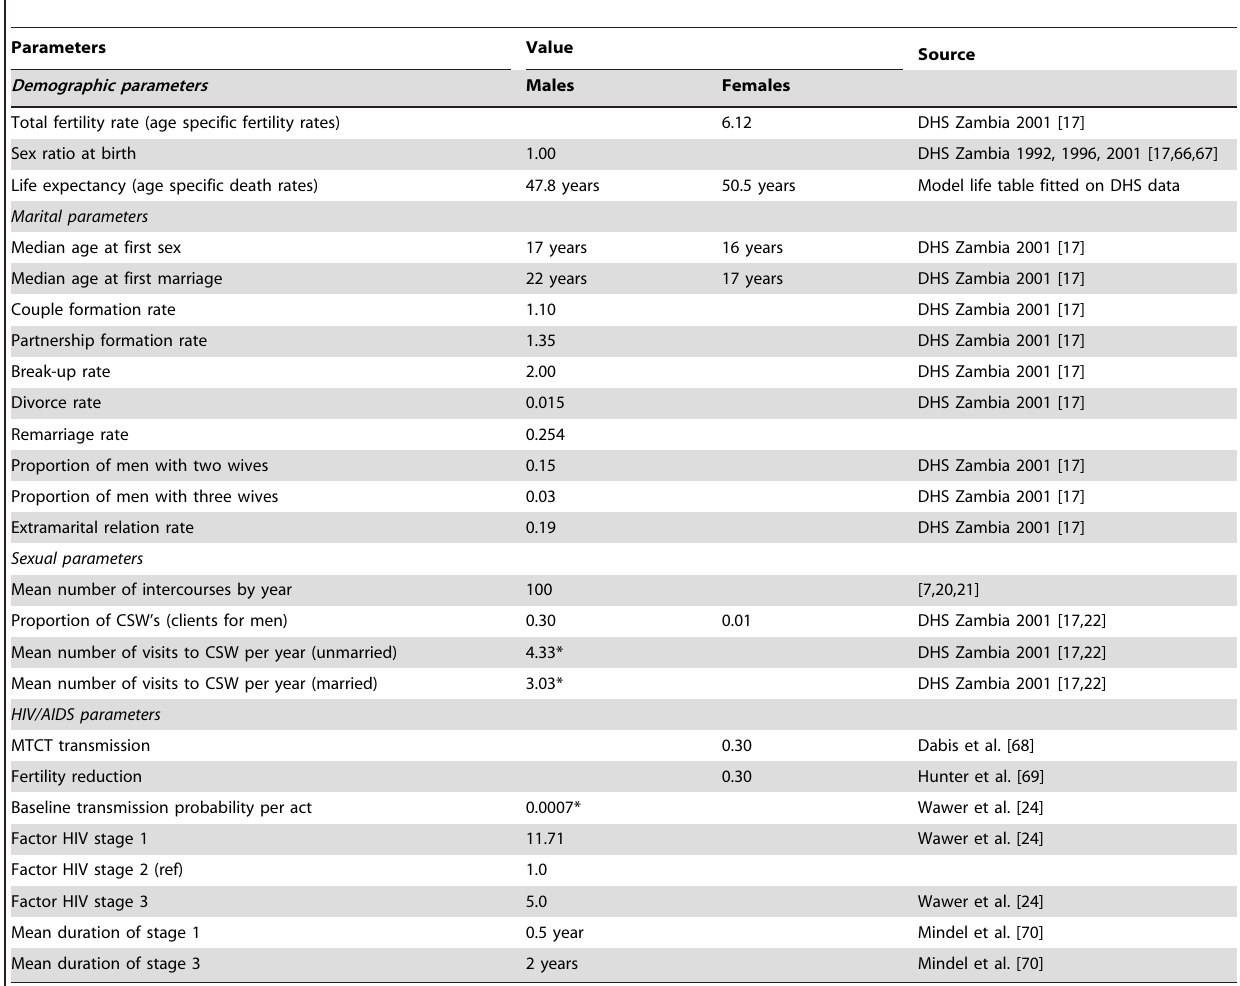
Table 1. Main parameters used in the model: values and